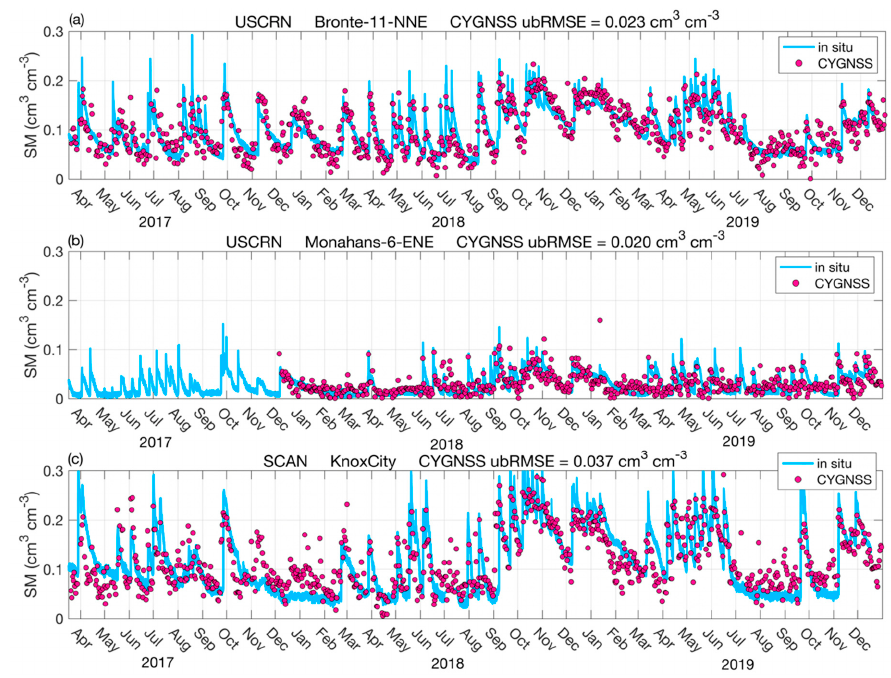
Figure 11. Examples of CYGNSS soil moisture retrievals that agree well with in-situ probes from three sites: USCRN Bronte-11-NNE ( a ), USCRN Monahans-6-ENE ( b ), and SCAN Knox City ( c ). CYGNSS retrievals from USCRN Monahans-6-ENE start in December 2017 because the elevation of the station is greater than 600 m. The values of ubRMSE shown for each station is for the validation time period only (October 2, 2018 – December 31, 2019).